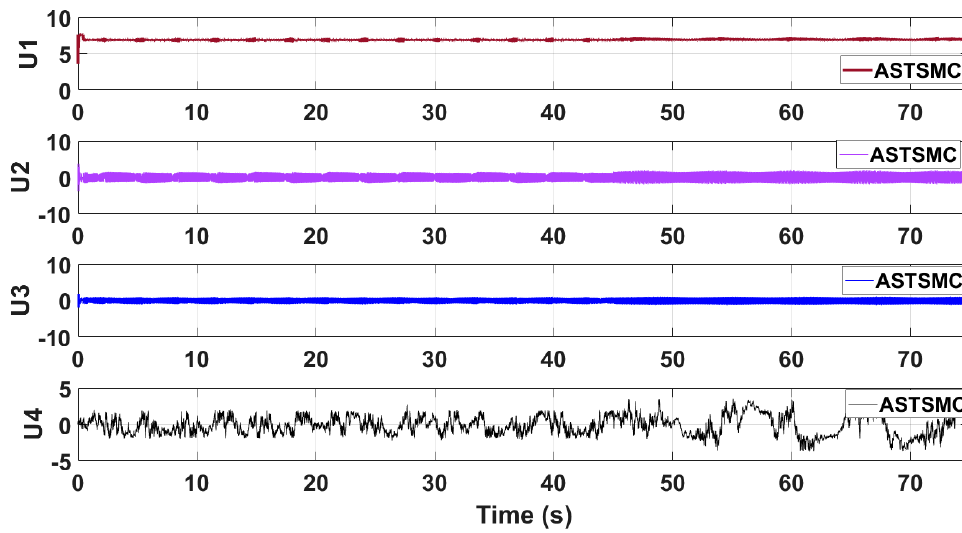
Figure 21. Control inputs using proposed control